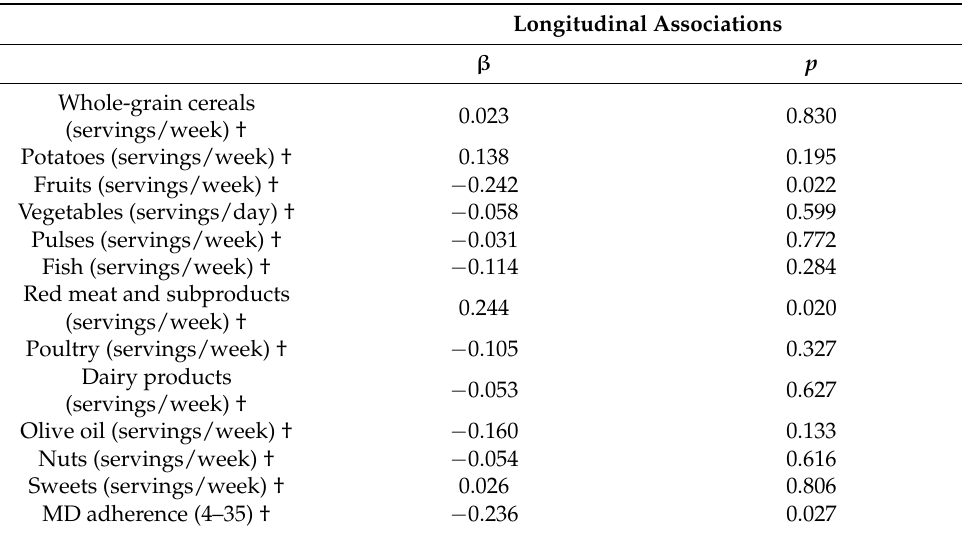
Table 3. Associations of dietary habits and MD adherence during pregnancy with postpartum depression severity (n = 85).